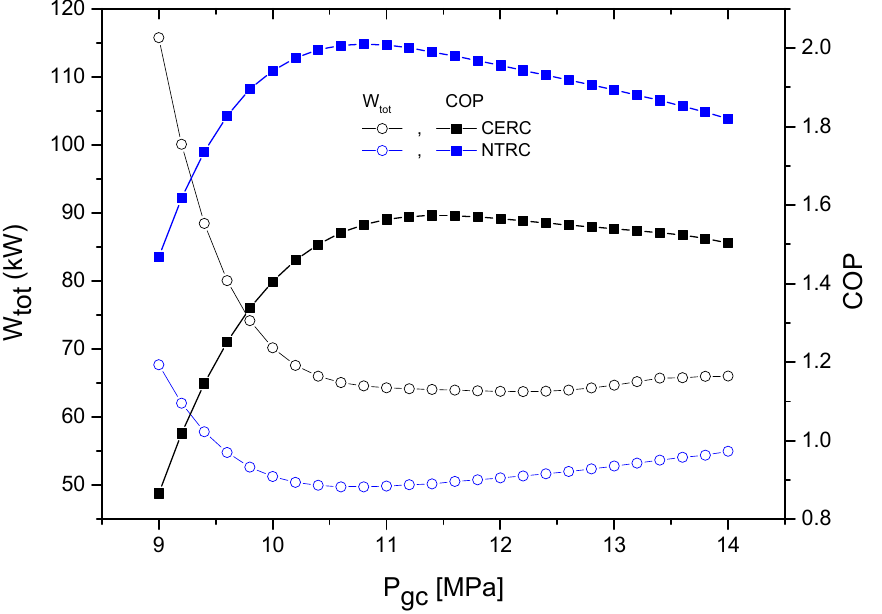
Figure 5. The coe ffi cient of performance (COP) and power consumption variation with P gc Figure 5. The coefficient of performance (COP) and power consumption variation with P gc.